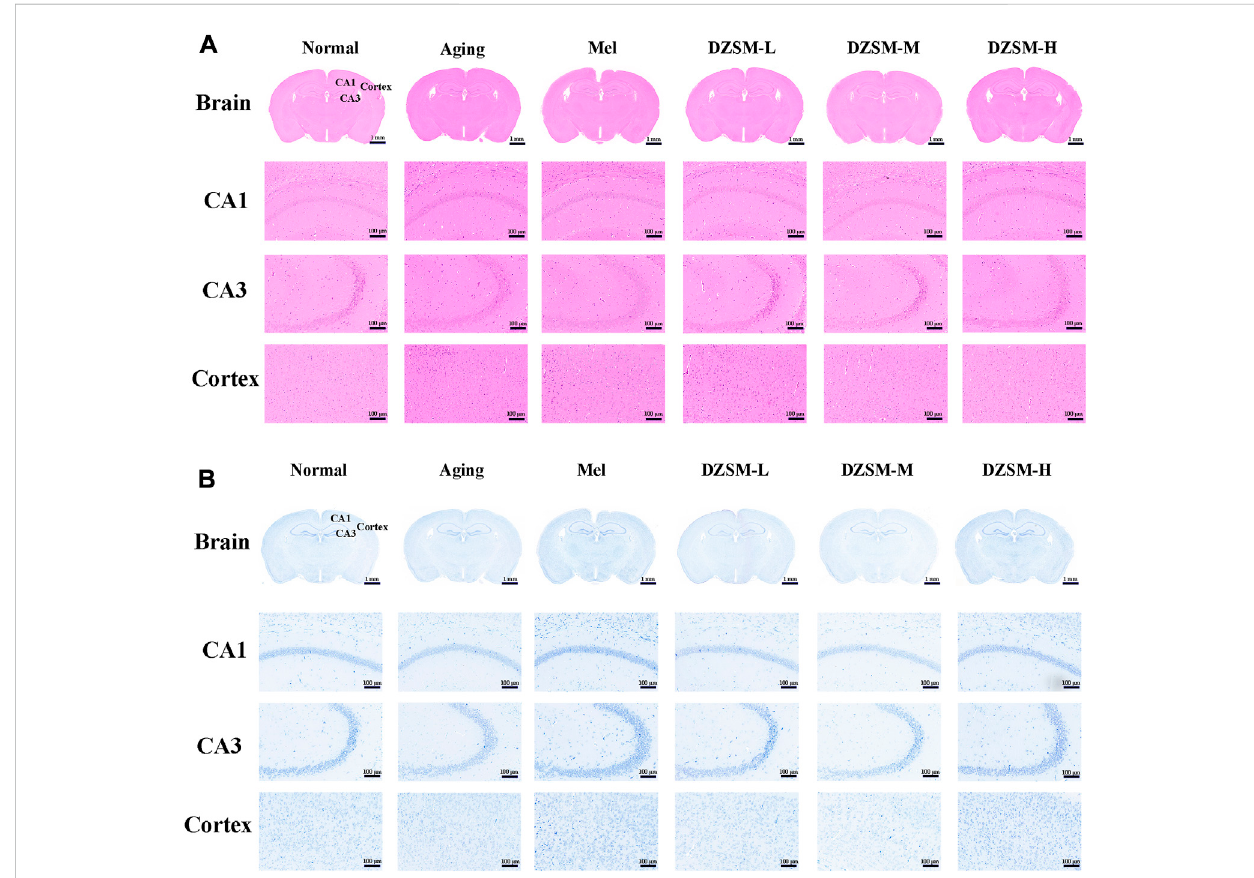
FIGURE 2 Histopathological changes in the brain tissue. (A) H&E staining; (B) Nissl staining ( n = 3). Bar length: 1 mm, 100 μ